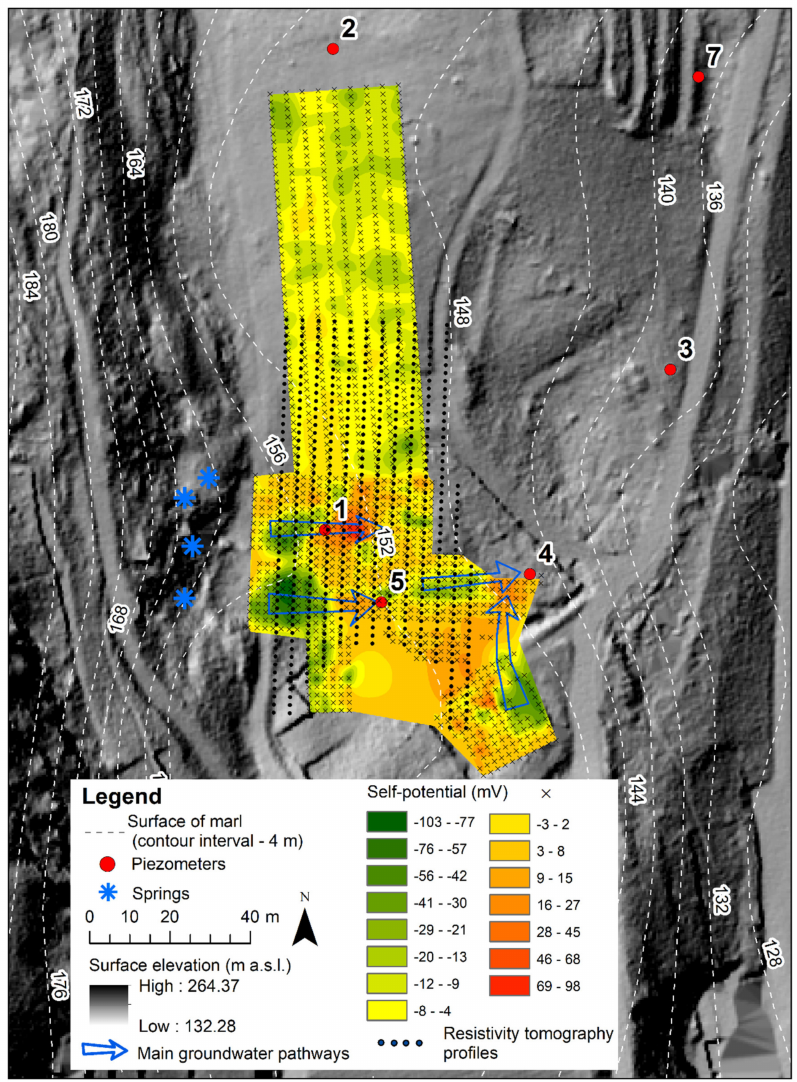
Figure 6. Location self-potential mapping in the study